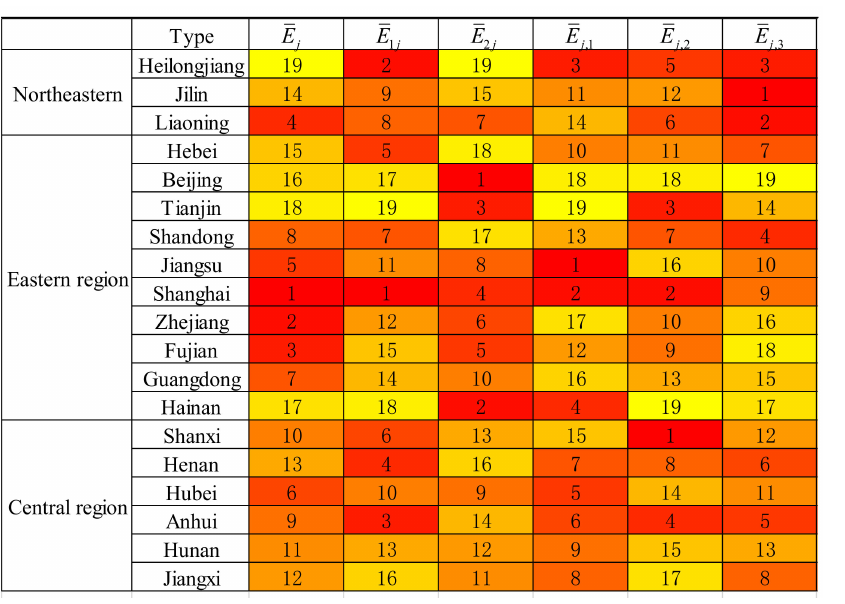
Figure 2. Ranking chart of different efficiency values in different province. (the efficiency value ranking is expressed in a gradual color from yellow to red. The redder the color of the color block, the higher the efficiency level ranking. The yellower the color of the color block, the lower the efficiency level